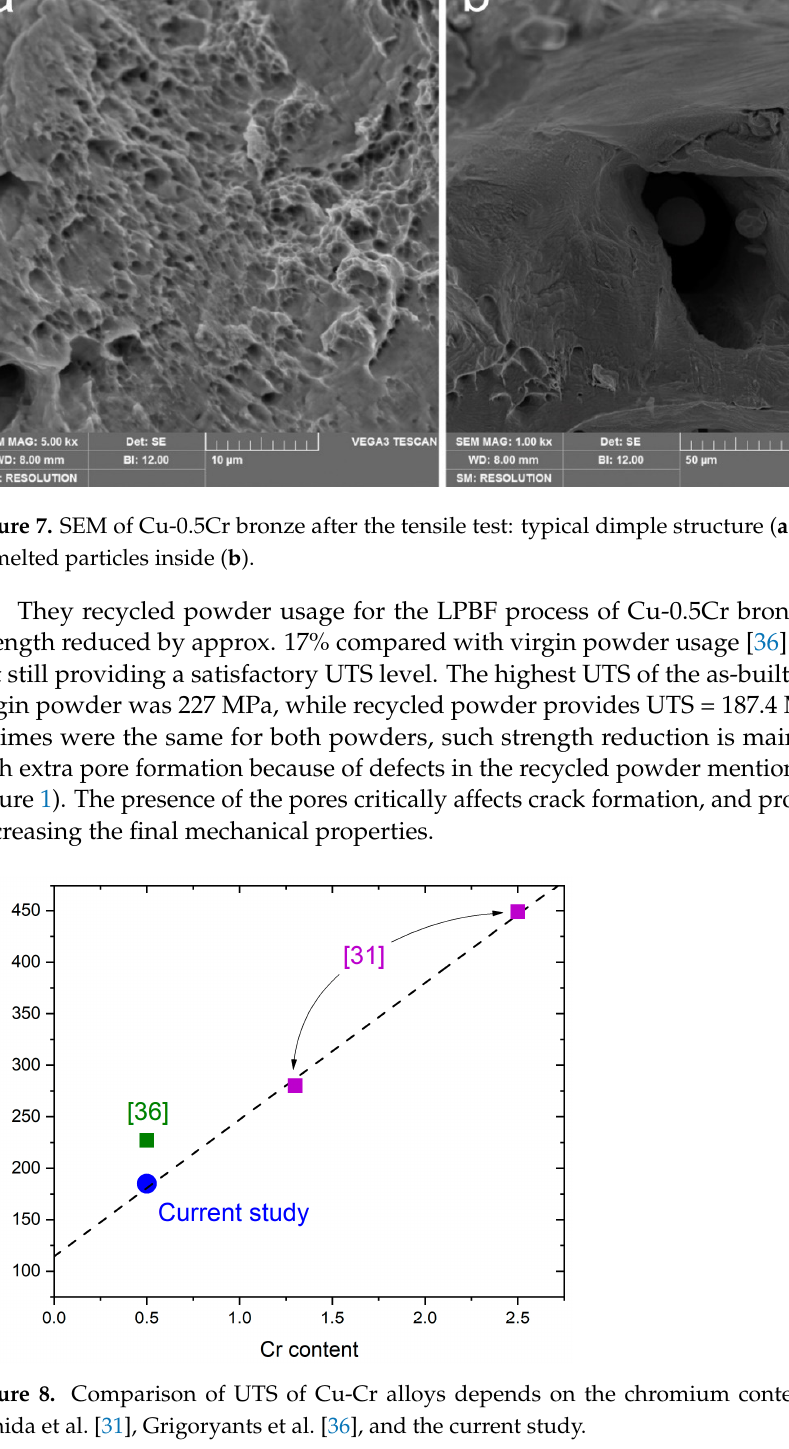
Figure 8. Comparison of UTS of Cu-Cr alloys depends on the chromium content obtained by Uchida et al. [31], Grigoryants et al. [36], and the current study.